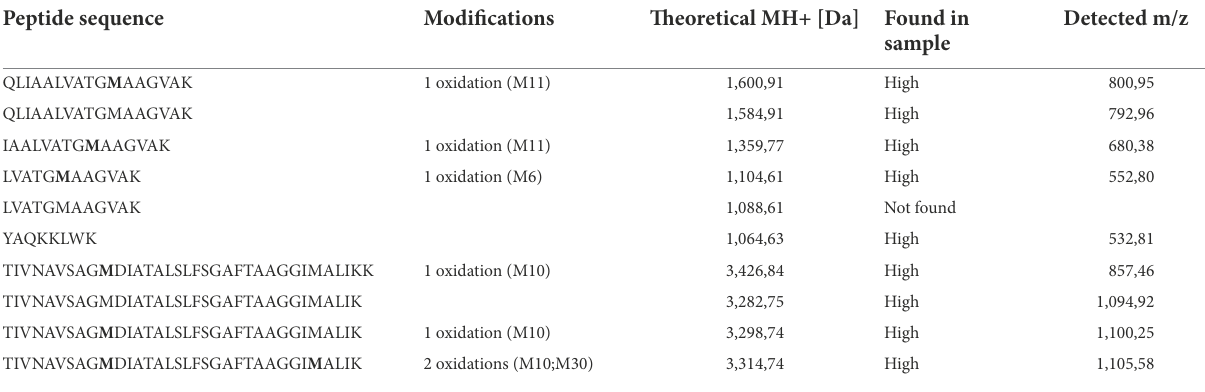
TABLE 3 Peptide fragments, identified by targeted proteomics combined with massive peptide analysis of the purified GarML in the RP-FPLC- derived eluates from the cellular soluble fraction (CSF) of the E. coli (DE3) (pCir-Npu-GarML) cultures. Peptide sequence